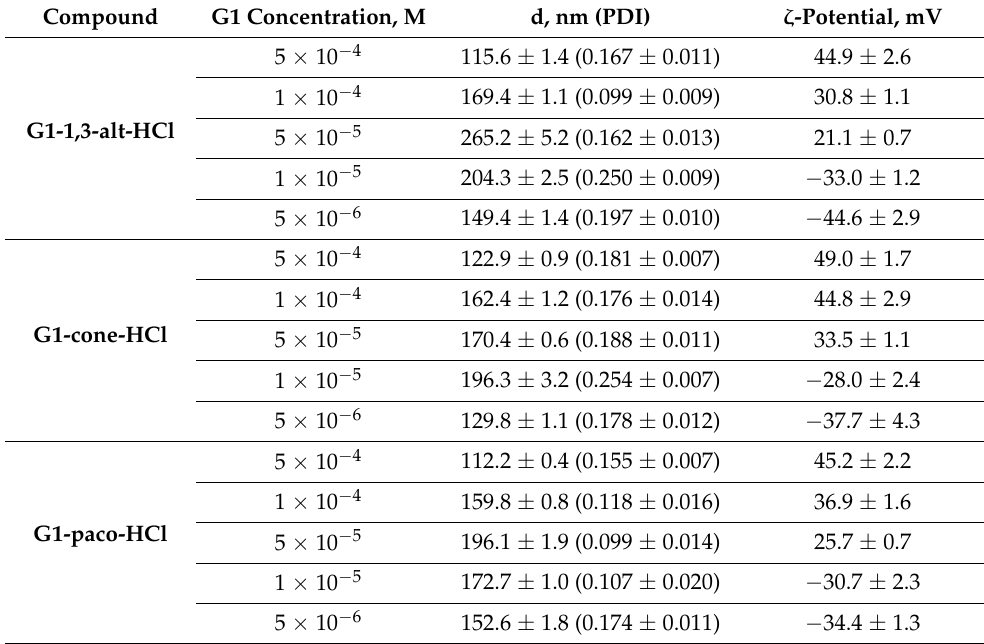
Table 1. Size distribution (intensity) and values of ζ -potential of G1-HCl with salmon sperm DNA